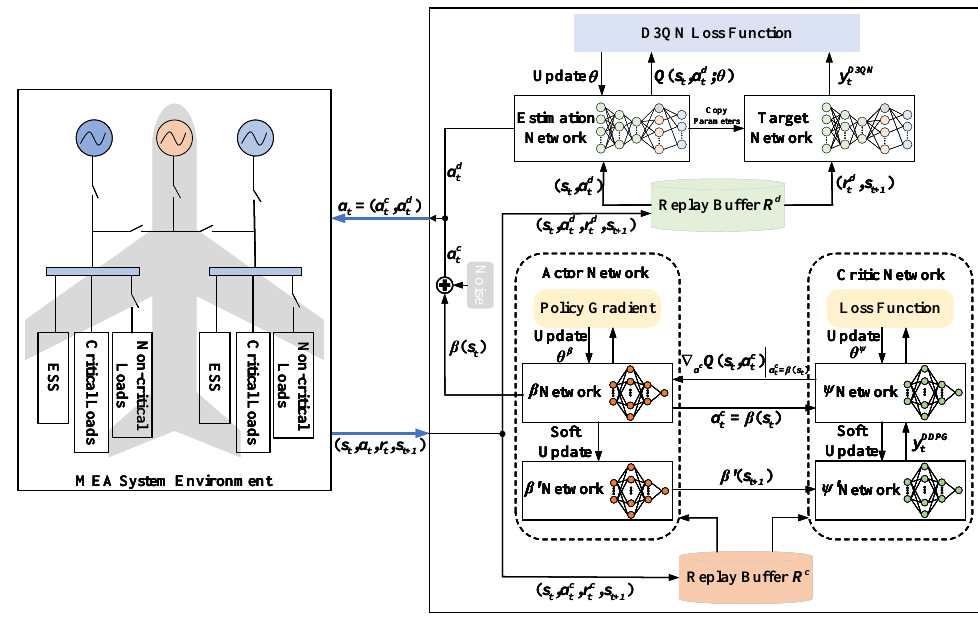
Figure 4. HDRL algorithm design mechanism.